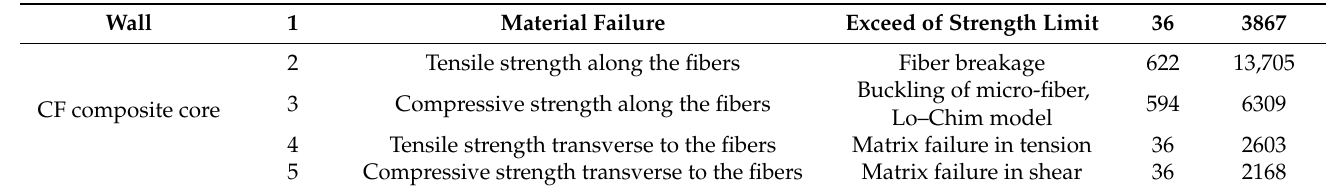
Table 5. Static analysis—limit states.